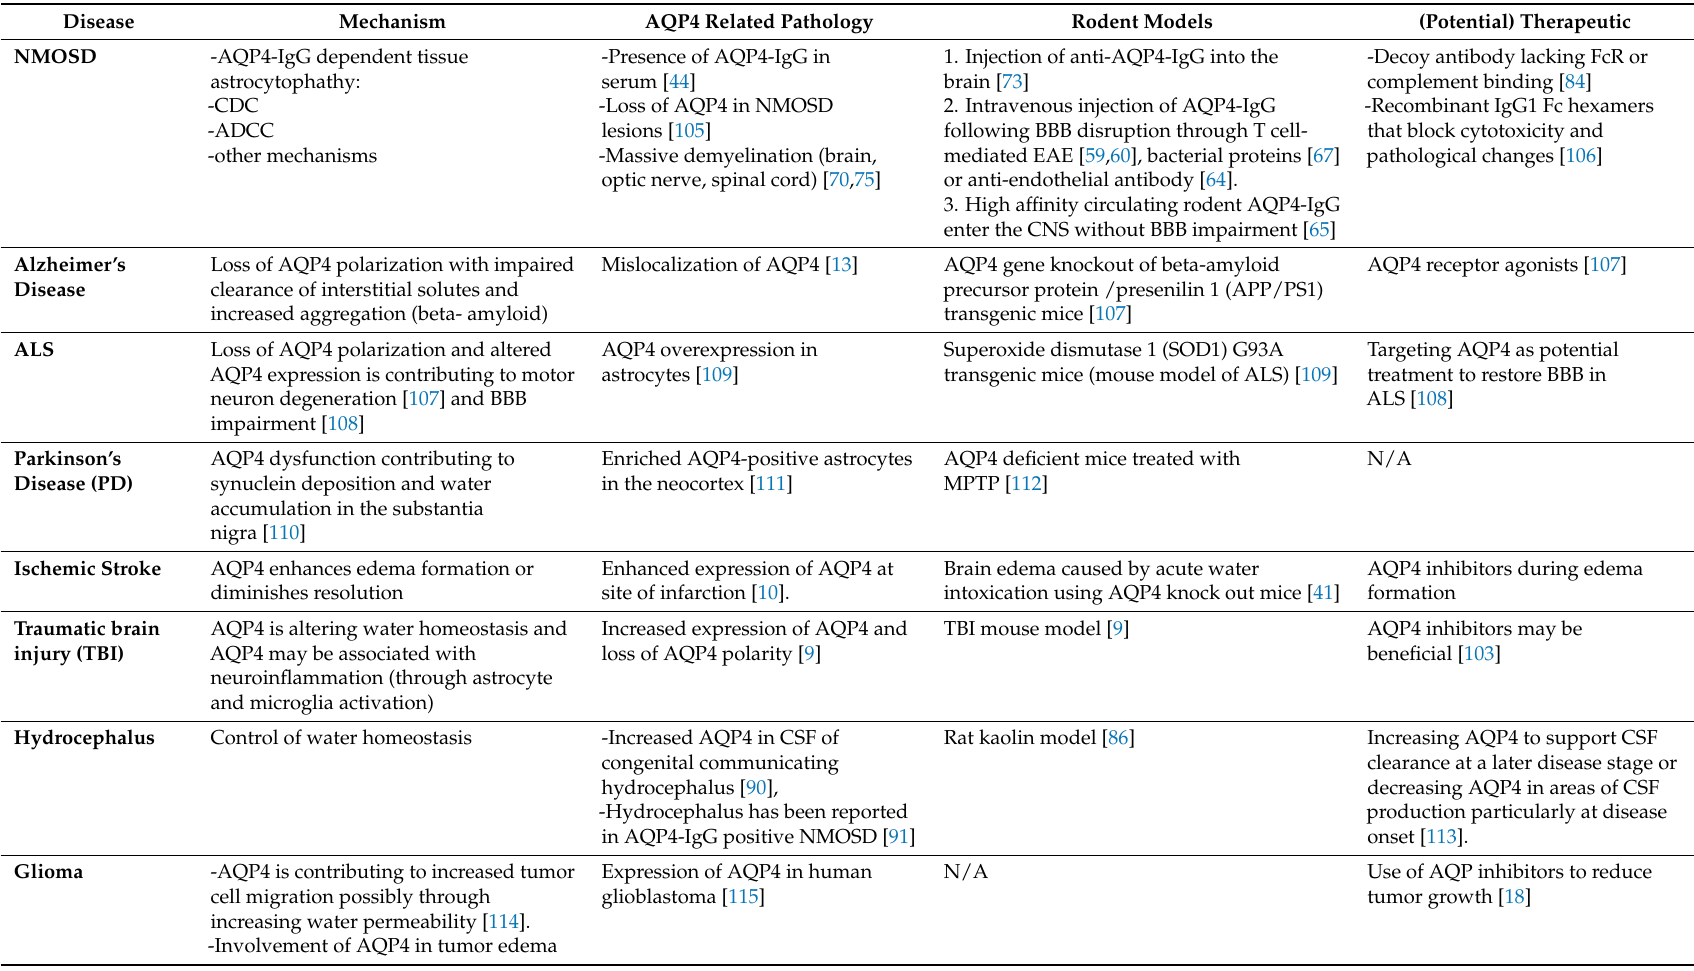
Table 1. AQP4 in different pathological